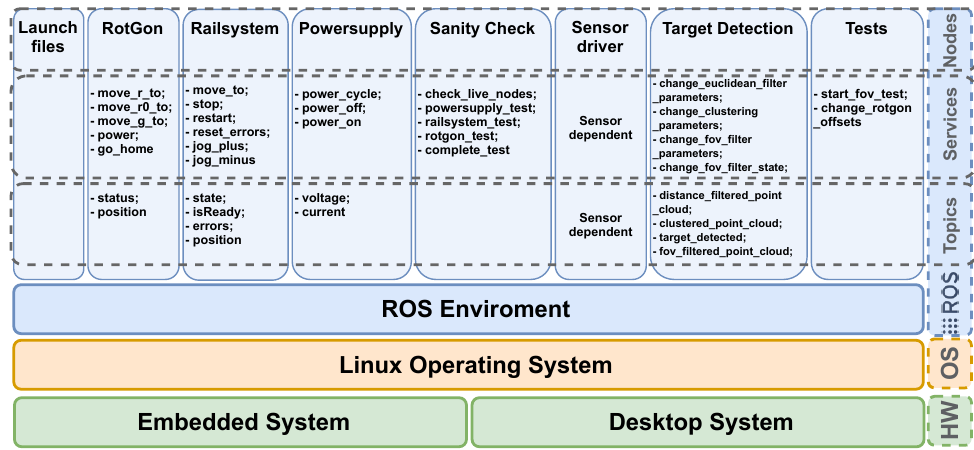
Figure 9. Software stack